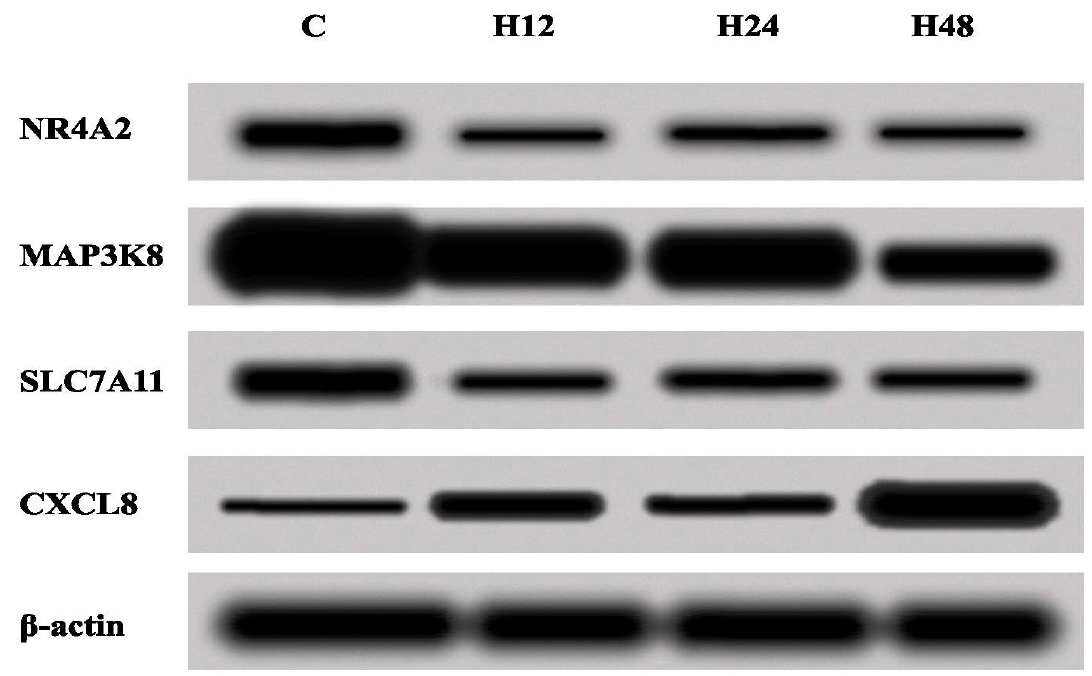
Figure 4. Expressions of NR4A2, MAP3K8, CXCL8 and SLC7A11 in the Ishikawa cell line treated with either cisplatin or salinomycin and a control culture, obtained via the Western blot technique. C—control; H_12, H_24, H_48—periods of exposure to cisplatin or salinomycin; NR4A2—nuclear receptor subfamily 4 group A member 2; MAP3K8—mitogen ‐ activated protein kinase kinase 8;